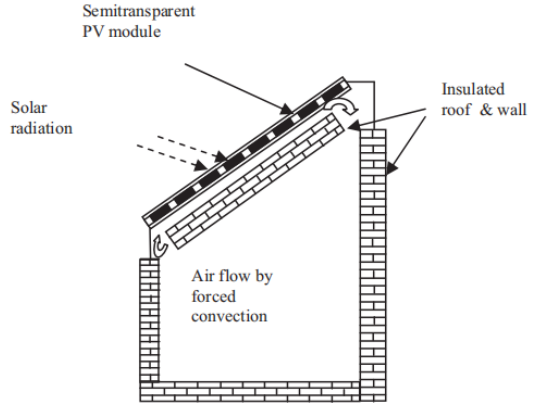
Figure 2. Schematic presentation of the tilted BIPV roof with semi-transparent PV with forced ventilation [19].